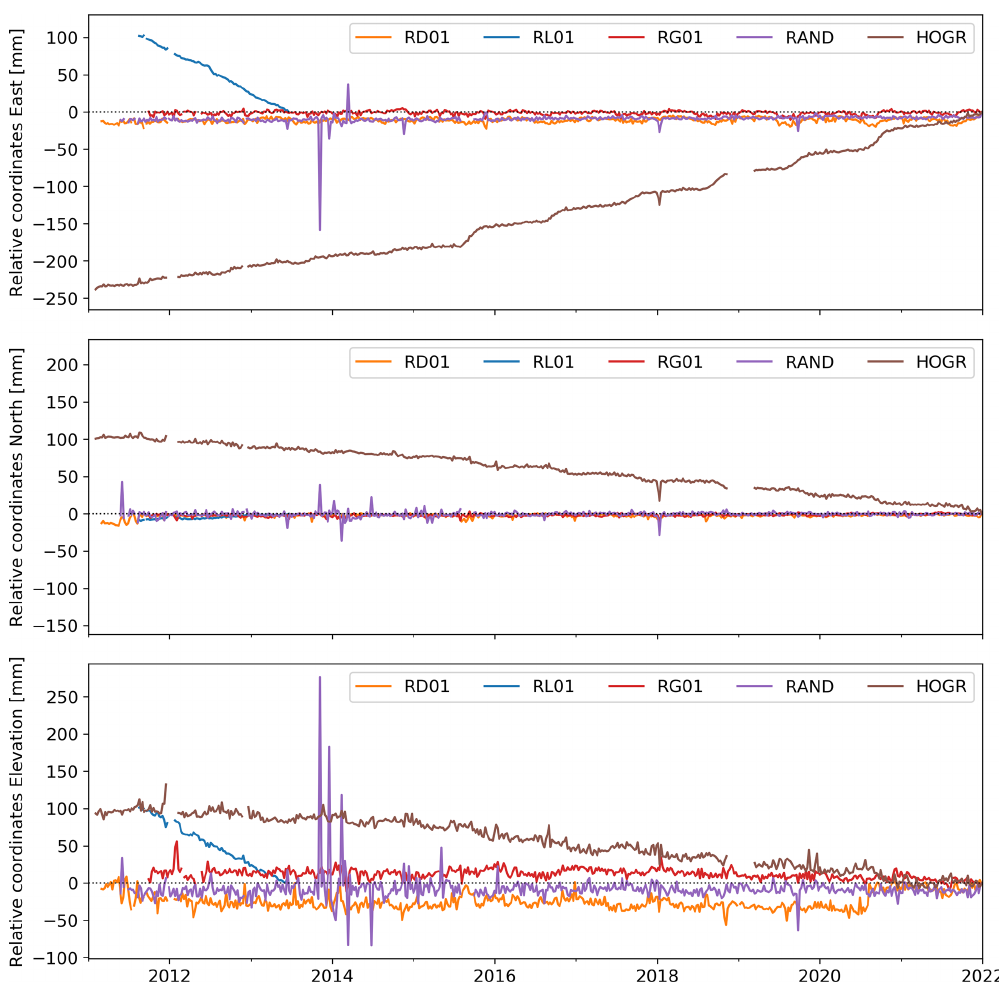
Figure A2. Time series (weekly mean) the three components of all reference stations used. A detailed description of each station is given in Table 2. For a discussion of the spike in HOGR that also appears in the nearby RAND, see Sect. 6.